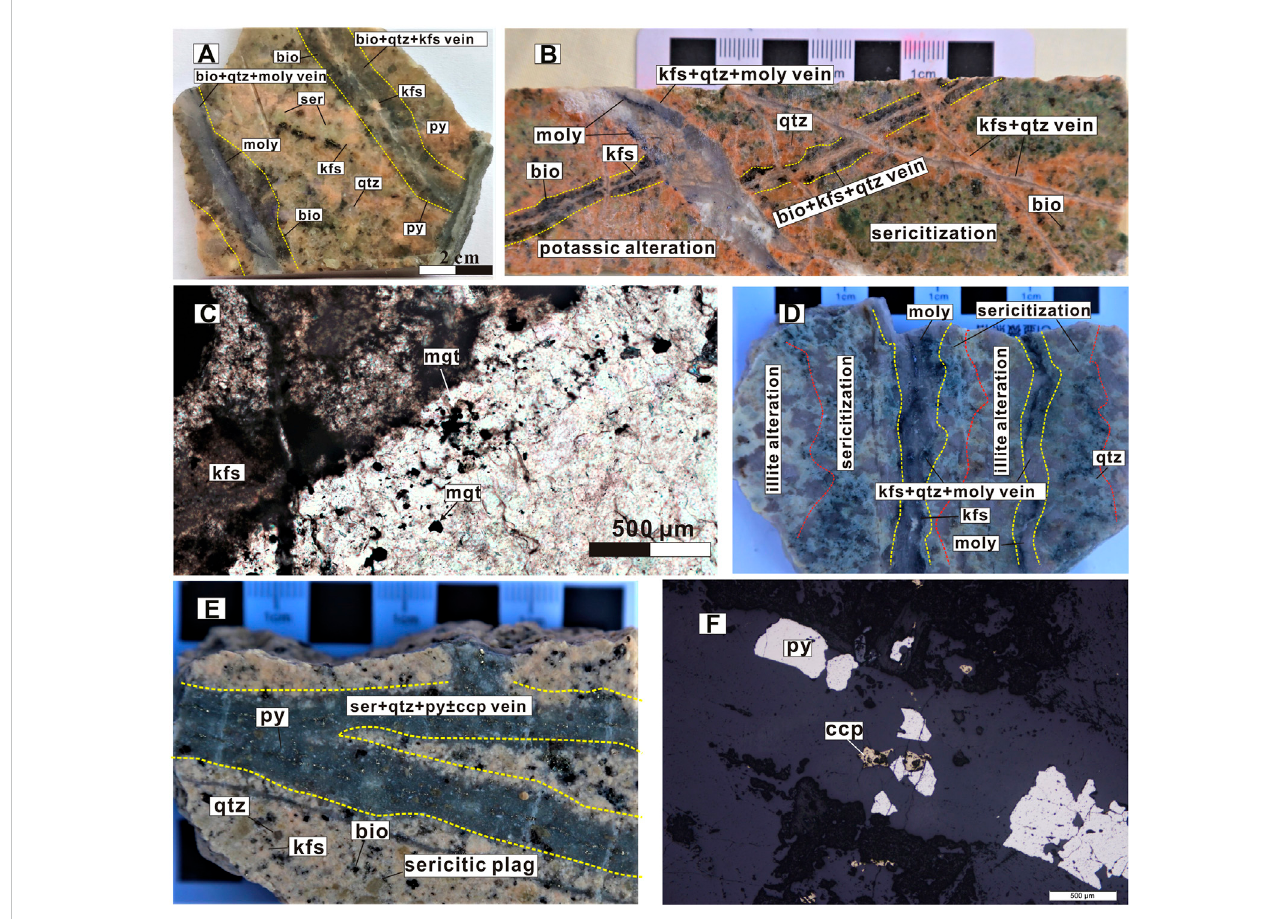
FIGURE 4 Alteration andmineralizationhostedinvariousquartzveins. (A) bio+qtz+molyvein,accompaniedwithbiotitization. (B) earlybio+qtz+kfs±molyvein is cut by kfs + qtz + moly vein, early K-feldspathization alteration is overprinted by sericitization. (C) kfs + qtz + moly vein, feldspar is replaced by illite. (D) sericite and illite distribute symmetrically on the two sides of kfs + qtz + moly vein. (E, F) ser+qtz+py±ccp vein. Abbreviations: kfs –